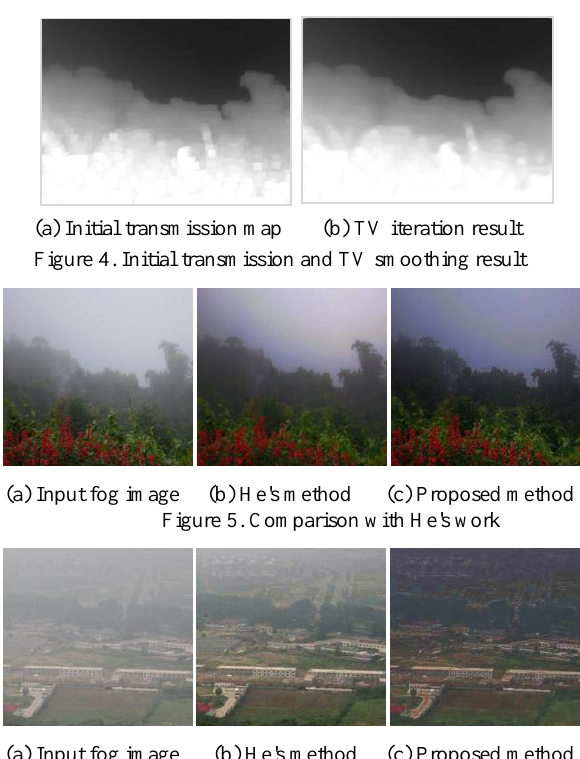
Figure 6. Comparison with He's work